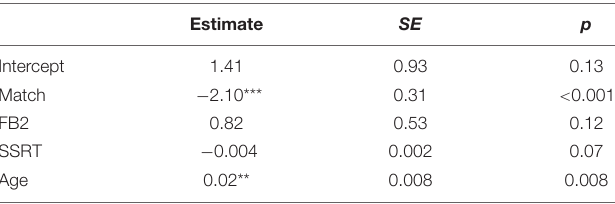
TABLE 7 | Estimated multiple mechanisms model of accuracy in object pronoun interpretation, including Age.